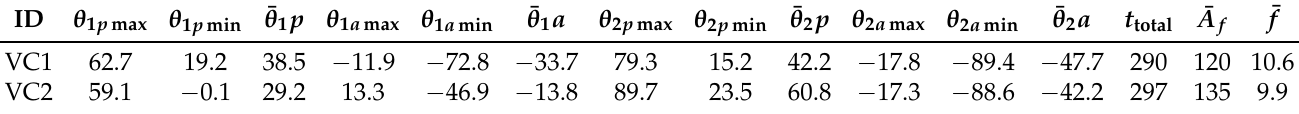
Table 4. Kinematics parameters of the butterfly obtained by experimental observation.